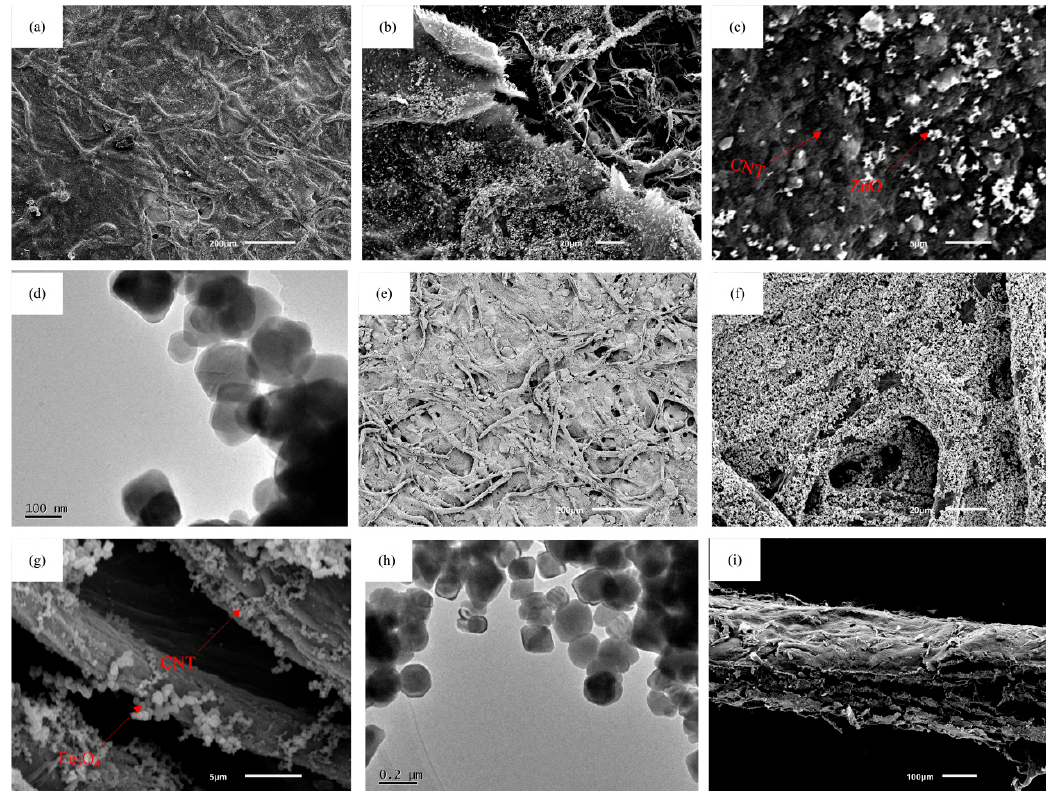
Figure 3. ( a ) Low power of the surface morphology image of the ZnO / CNT / FP electrode; ( b ) SEM image of the cellulose fiber of the ZnO / CNT / FP electrode; ( c ) high power image of the ZnO / CNT / FP electrode; ( d ) TEM image of the ZnO / CNT / FP electrode; ( e ) low power of the surface morphology image of the Fe 3 O 4 / CNT / FP electrode; ( f ) SEM image of the cellulose fiber of the Fe 3 O 4 / CNT / FP electrode; ( g ) high power image of the Fe 3 O 4 / CNT / FP electrode; ( h ) TEM image of the Fe 3 O 4 / CNT / FP electrode; ( i ) section morphology images of the AS.